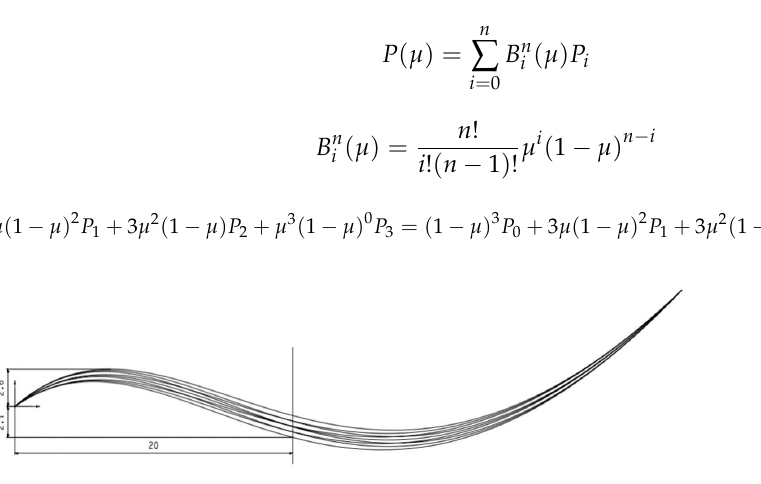
Figure 1. Schematic diagram of Bezier cubic curve. The curved inner cup structure changed the air flow field, wind speed, and pressure field in the cup and reduced the inflow of external hot air (as shown in Figure 2). Finally, the purpose of improving the constant temperature water holding capacity of the sam- pling cup without increasing the depth of the sampling cup to ensure the sampling capac- ity and stability was achieved.